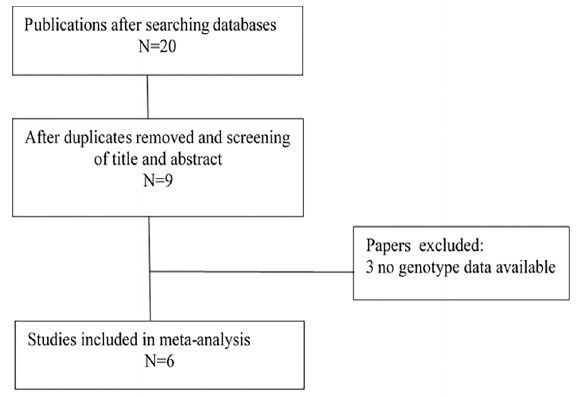
Table 2. rs6265 polymorphism was signi fi cantly asso- ciated with cognitive impairment in PD in 2 models (AA vs GA + GG and AA vs GA; Figure 2). Strati fi cation analyses showed this association was signi fi cant among Caucasian populations in 3 models (AA vs GA + GG, AA vs GG, and AA vs GA; Figure 3).